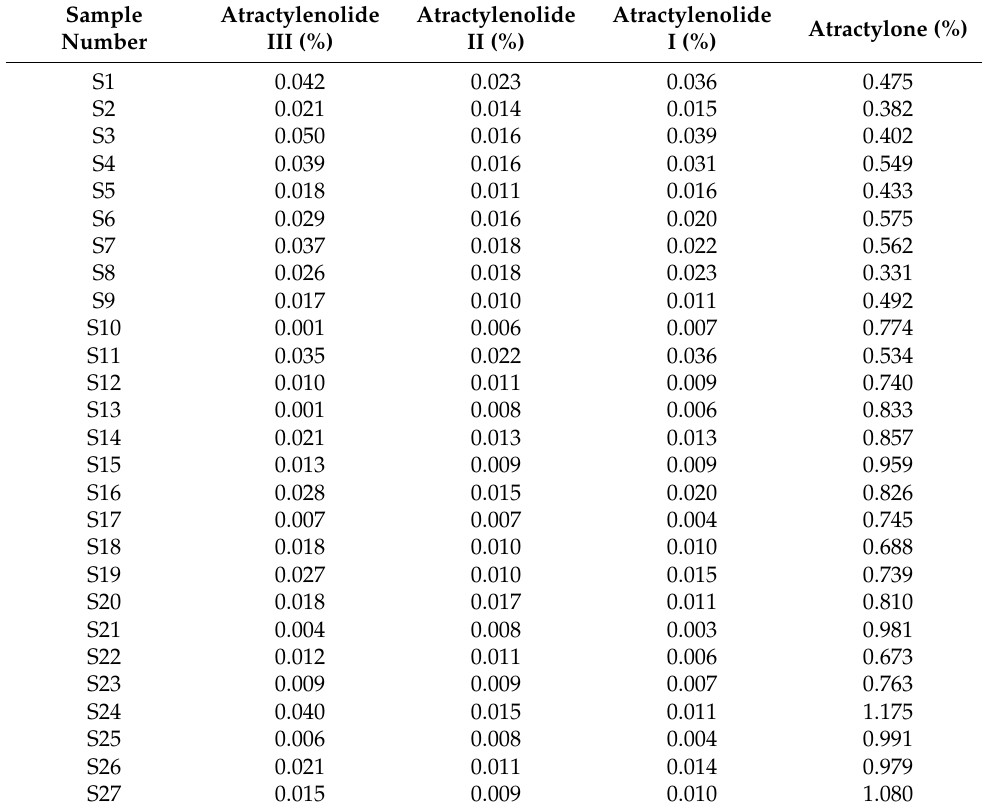
Table 5. The contents of four